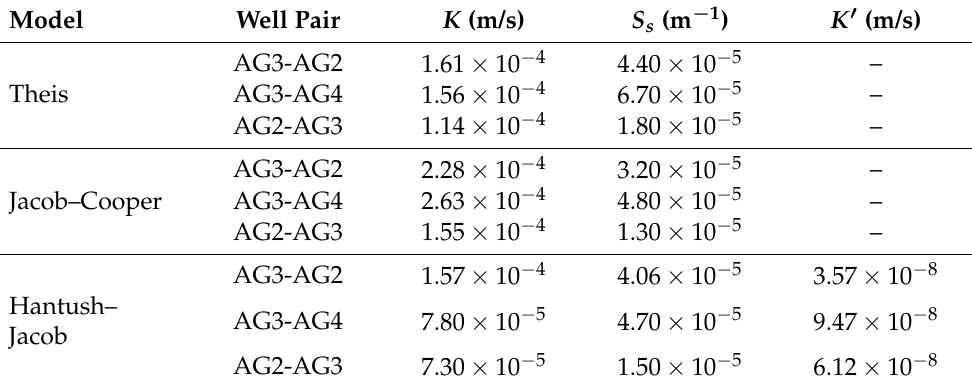
Table 3. Model estimates of hydraulic parameters from aquifer drawdown data.